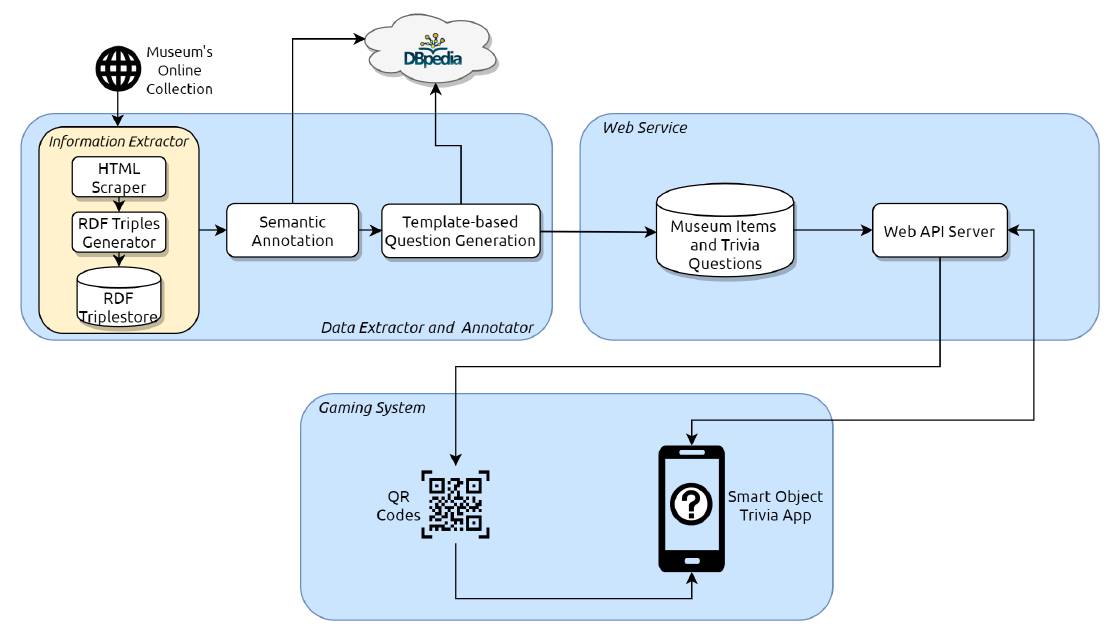
Figure 3. Gamified Smart Objects Platform